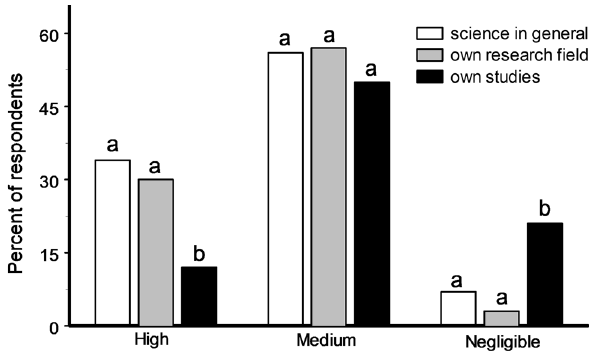
Figure 1. Impact of biases on science in general, on one’s own research field and on one’s own studies, as estimated by 301 respondents. Bars marked with different letters differ from each other at P < 0.05 within each group ( χ 2